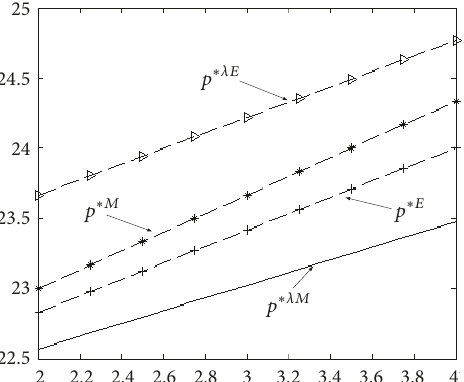
Figure 6: Change rule of network platform’s profit as 𝜌